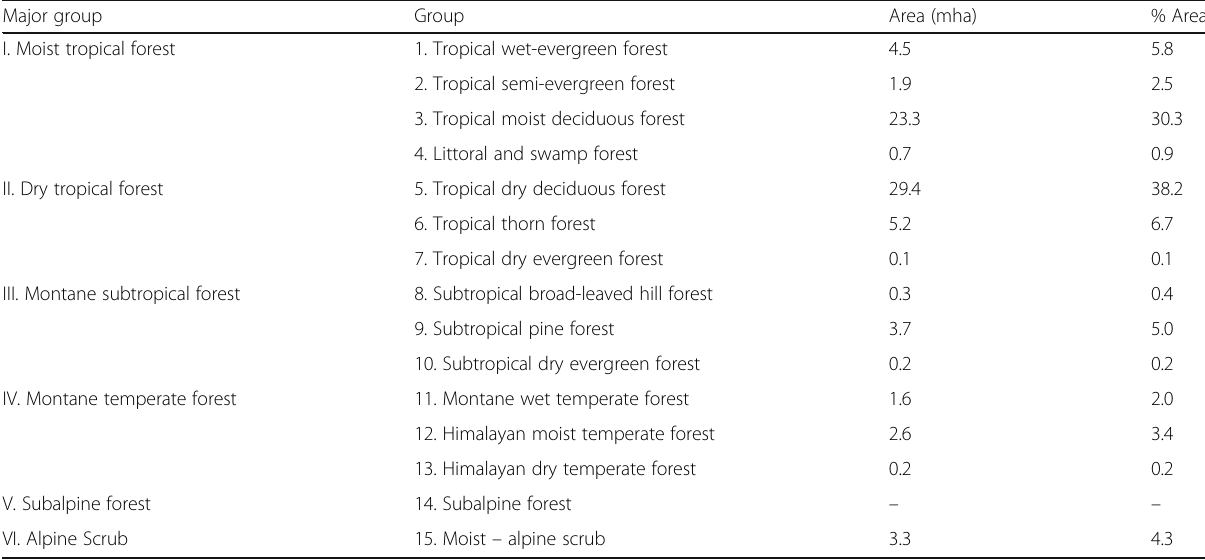
Table 1 Major forests groups of Indian forest and their area Major group